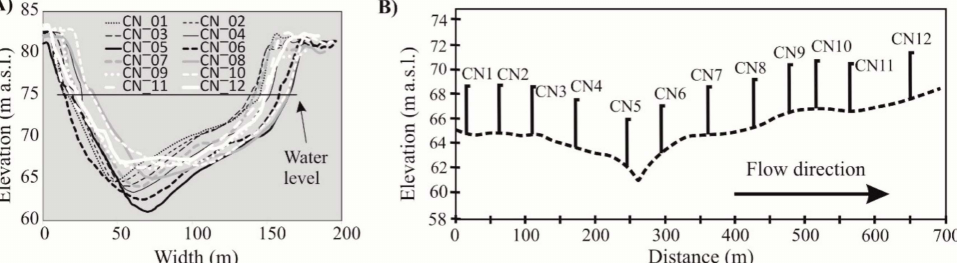
Figure 5. Cross-sectional channel profiles ( A ) and longitudinal thalweg profile ( B ) at the Csanytelek North study